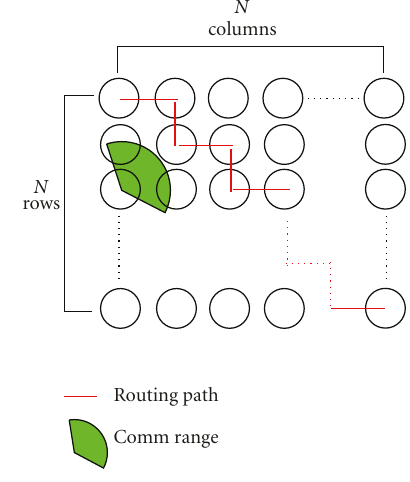
Figure 12: Lattice like scenario with the two opposite nodes on the diagonal willing to exchange data. The total number of nodes, figure relevant for the scalability of the package is a parameter in the